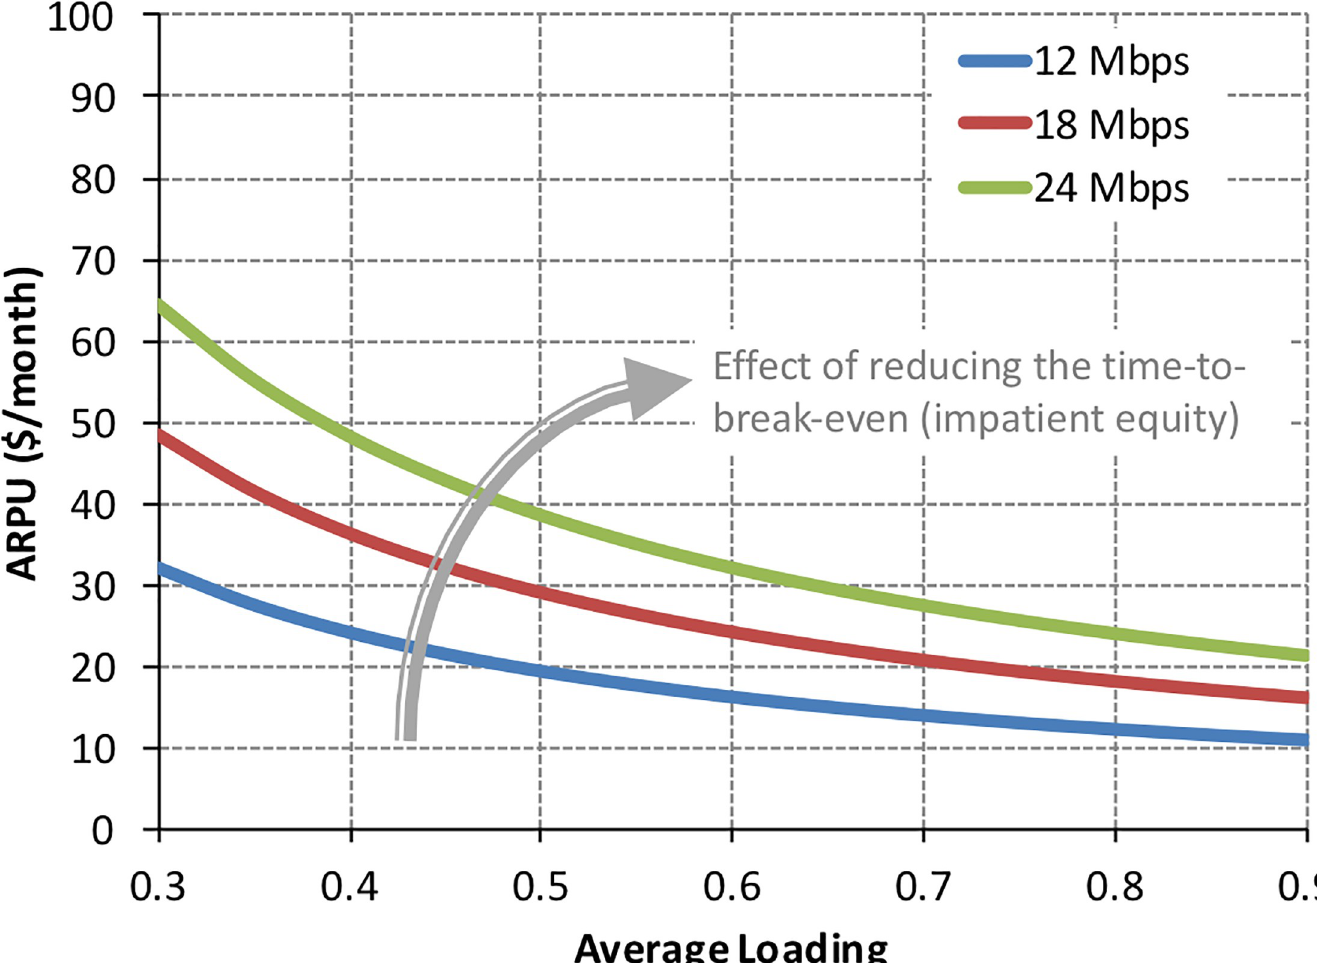
Fig 12. Required ARPU versus average loading for the medium-sized HTS to break-even in 10